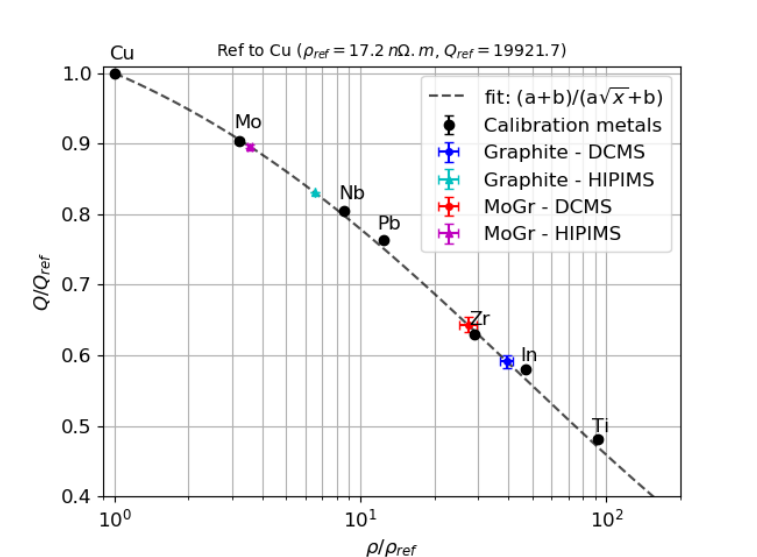
Figure 22. Measured Q variation for Mo coatings on MoGr and graphite substrates obtained with HIPIMS and DCMS. The reference material is copper, ρ ref = 17.2 n Ω m, with Q ref =